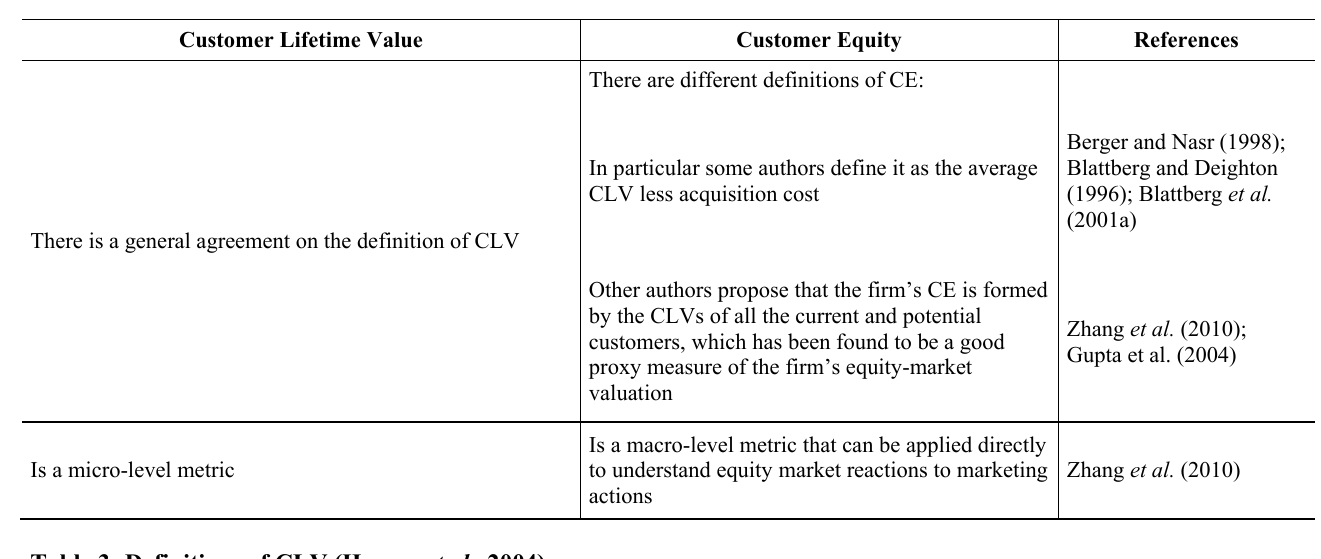
Table 2: Comparison between CLV and CE